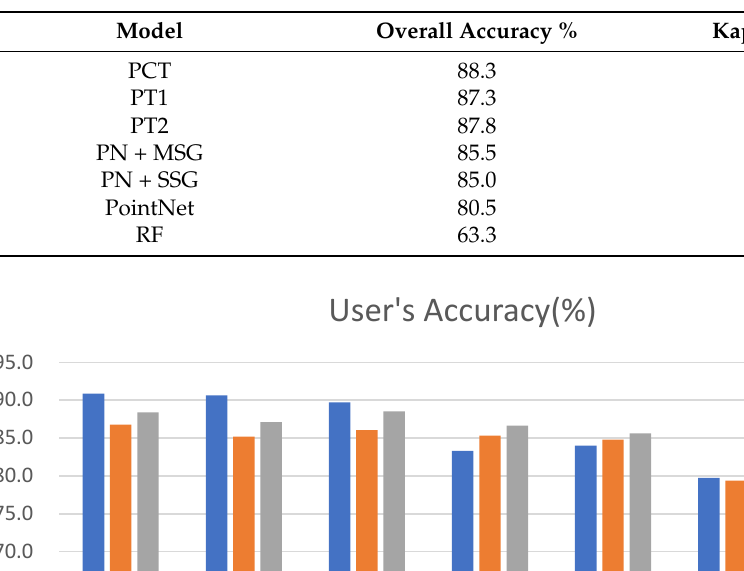
Table 4. Comparison of classification accuracy of seven models.